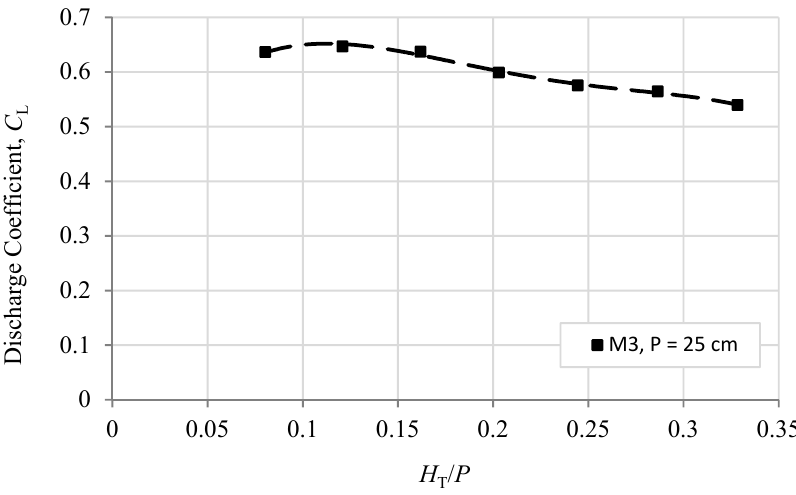
Figure 7. Variations in the discharge coefficient, C L , as a function of the H T /P ratio for the M3 model.